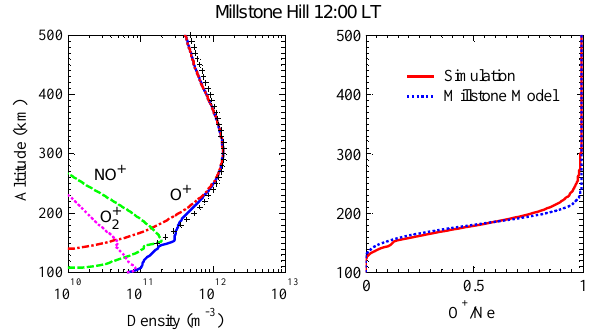
Figure 2. Example of the comparison between the observed electron profile (symbol ‘+’) and the Fig. 2. Example of the comparison between the observed electron model (solid line) on 27 September 2000, and O + , O 2+ , and NO + concentrations are also presented profile (symbol “+”) and the model (solid line) on 27 September (left panel). In right panel, calculated O + / Ne are compared to the Millstone Hill standard 2000, and O + , O + , and NO + concentrations are also presented 2 (left panel). In right panel, calculated O + / Ne are compared to the ion-composition model. Millstone Hill standard ion-composition